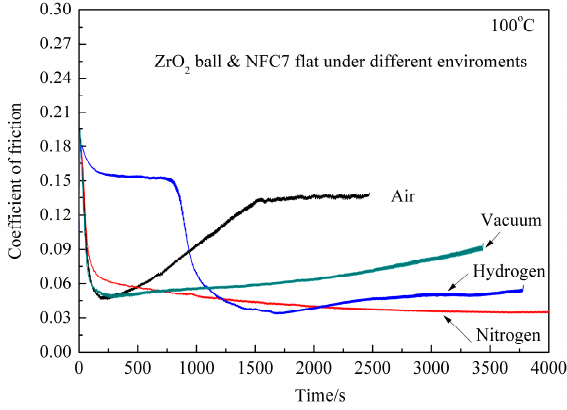
Figure 3. CoF of ZrO 2 ball/DLC films under different environments at 100 °C.